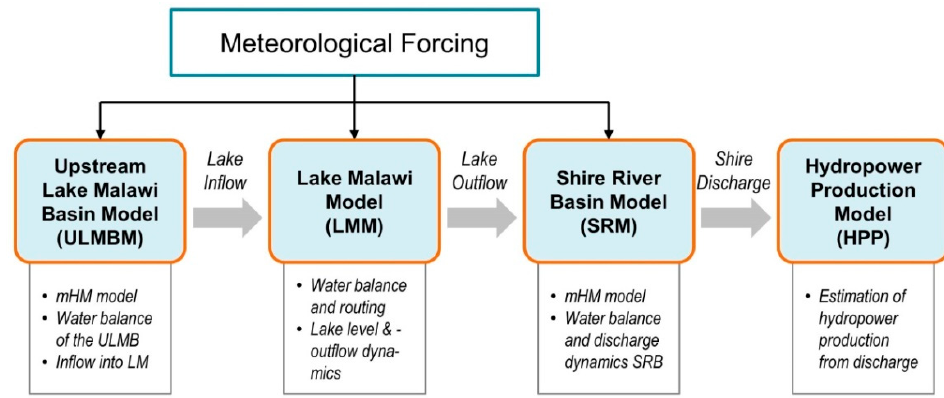
Figure 3. Conceptual overview of the hydrological model cascade applied in this study. The Mesoscale Hydrological Model mHM is used to dynamically simulate hydrological flows for the upstream Lake Malawi Basin (Upstream Lake Malawi Basin Model, ULMBM) and the upper and middle Shire River Basin (Shire River Model, SRM). A lake model (Lake Malawi Model, LMM) has been developed to dynamically simulate the water budget, lake levels and outflow dynamics of Lake Malawi. The models are driven by meteorological forcings, and model outputs from previous steps in the model cascade serve as inputs for lower model chain components. The hydropower production model (HPP) estimates hydropower generation on the Shire River.